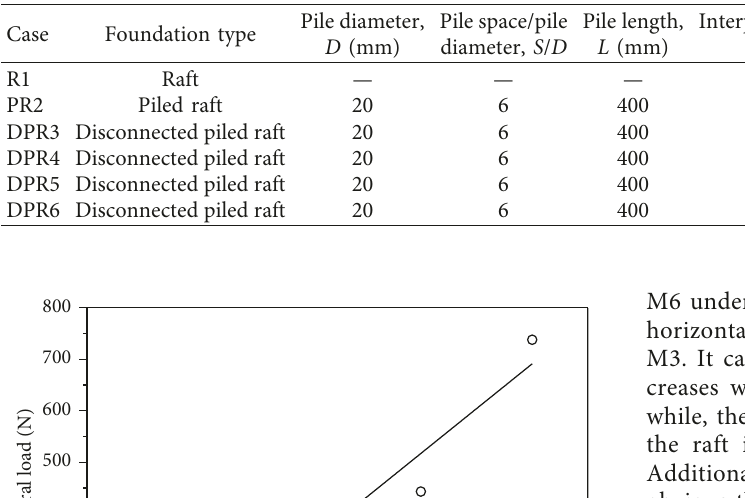
Table 3: Test arrangement.